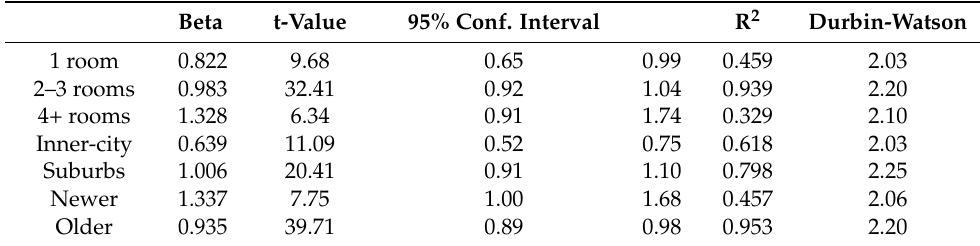
Table 4. The beta-analysis (Cochrane–Orcutt